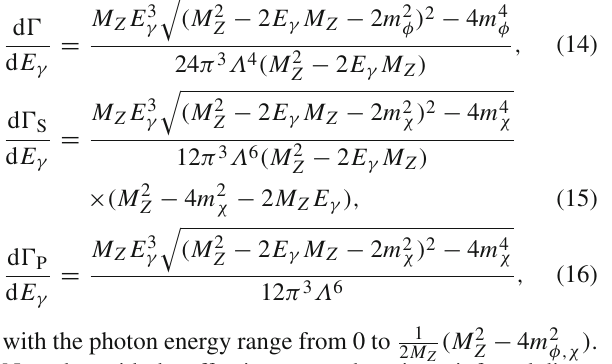
at 200GeV. The blue, red, green (dash) line denote